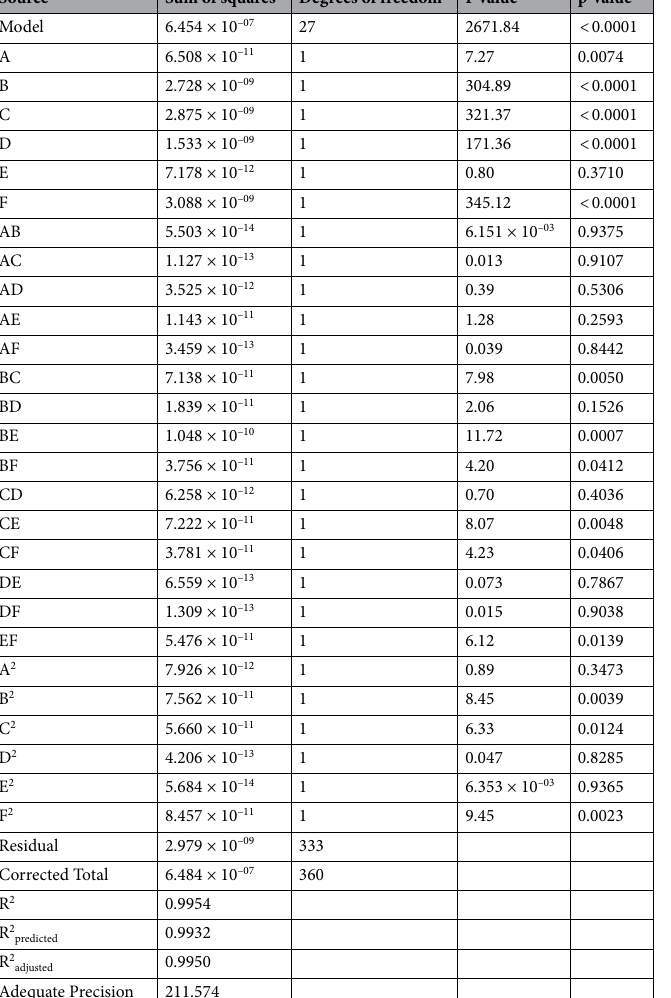
Table 4. Analysis of variance of the RSM model for output parameter.